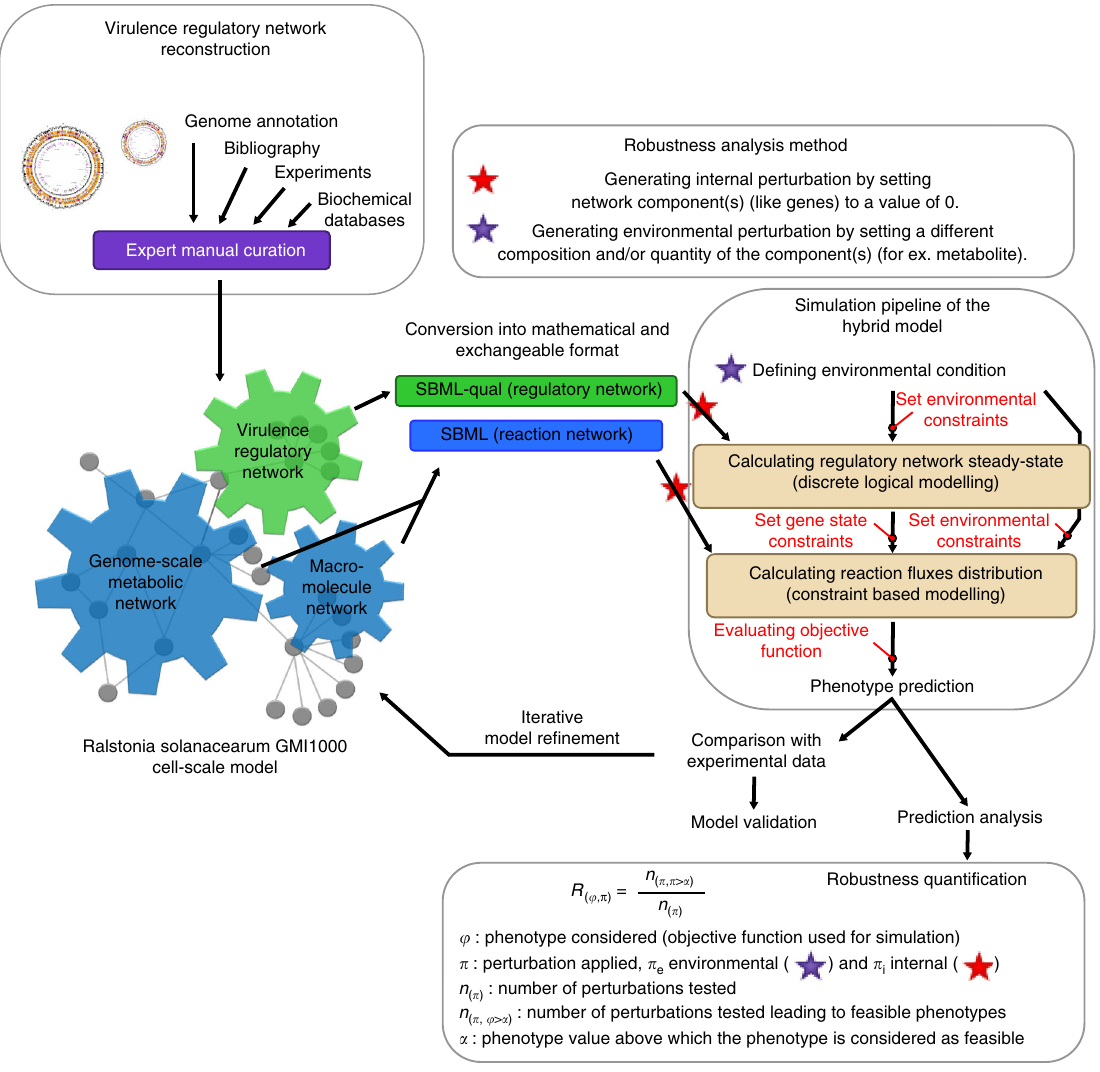
Fig. 2 Architecture of the cell-scale model of Ralstonia solanacearum GMI1000 and the simulation pipeline for robustness analysis. The cell-scale model is composed of three modules: a genome-scale metabolic network, a macromolecule biosynthesis and secretion module 45 , and the virulence regulatory network (VRN). Simulation was performed using hybrid modeling, i.e., discrete logical modeling for the regulatory network and constraint-based modeling for the biochemical reaction network. Robustness quanti fi cation was performed using the BECO analysis, which evaluates impact of environmental perturbations ( π e) or internal perturbations ( π i) on